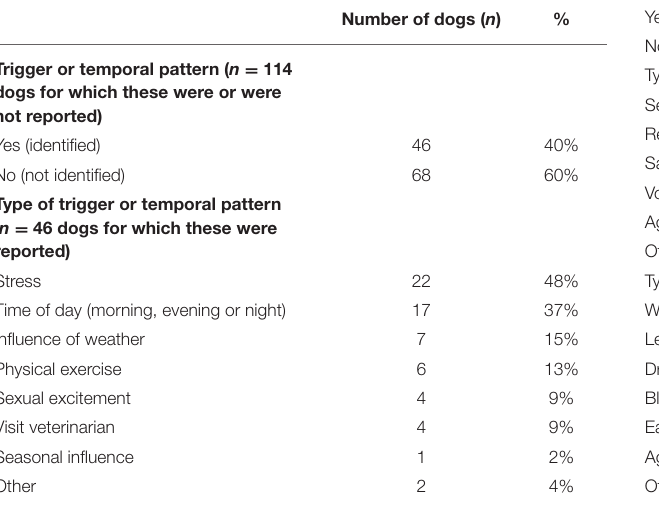
TABLE 4 | Triggers or temporal patterns identified by